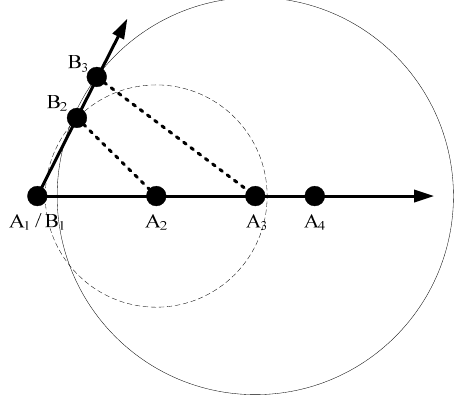
Figure 6. Novel definition of opposite path